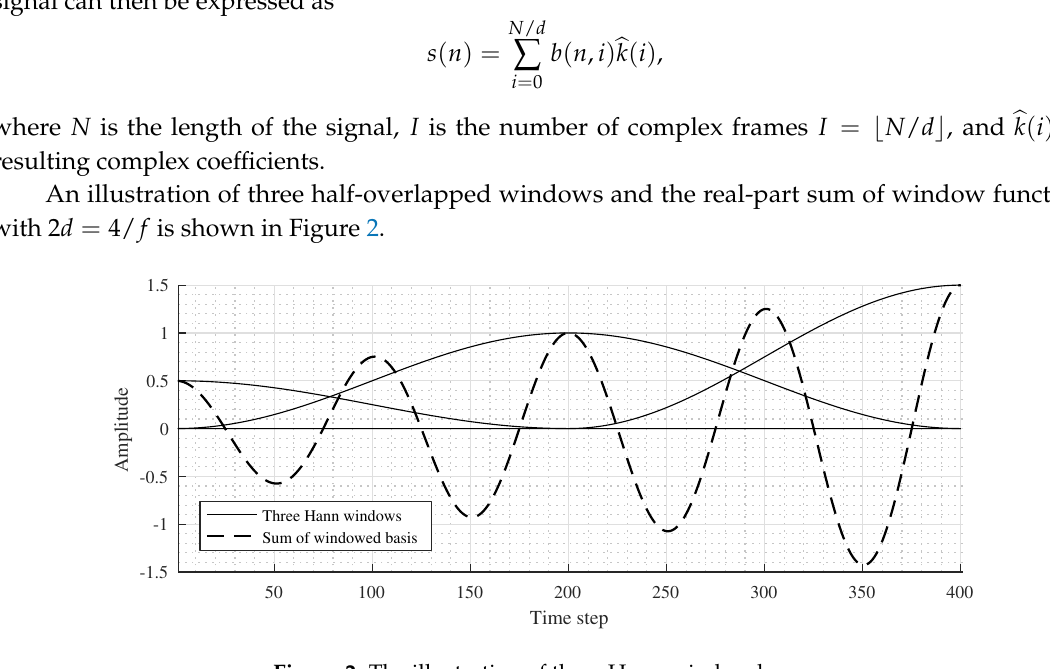
Figure 2. The illustration of three Hann window